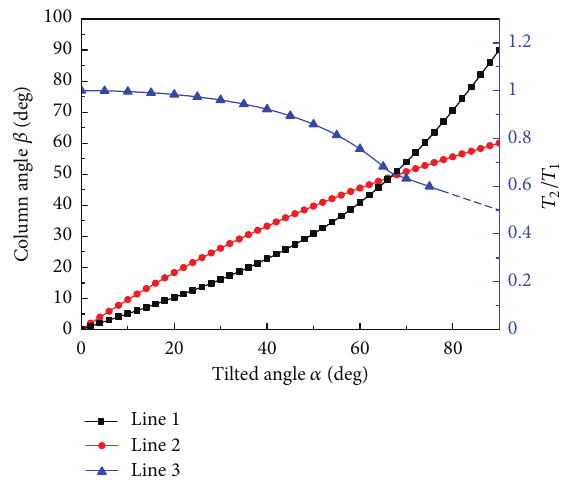
Figure 6: The relationship between column angle and the tilted angle, the blue line shows the ratio of actual film thickness to the thickness monitored by quartz-crystal oscillator